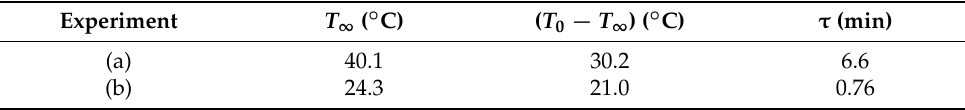
Figure 2. The kC temperature as a function of time during the printing stages: ( a ) cooling down from the loading temperature to the extruding temperature (the experiment at 40 °C is shown); ( b ) cooling down of the generated droplet (see text) after extrusion, during the self-supporting stage. The droplet was printed at 40 °C on the printer plate kept at 25 °C. Lines correspond to the best fit of the data to Equation (1). Table 1. Cooling rate and regression parameter values.